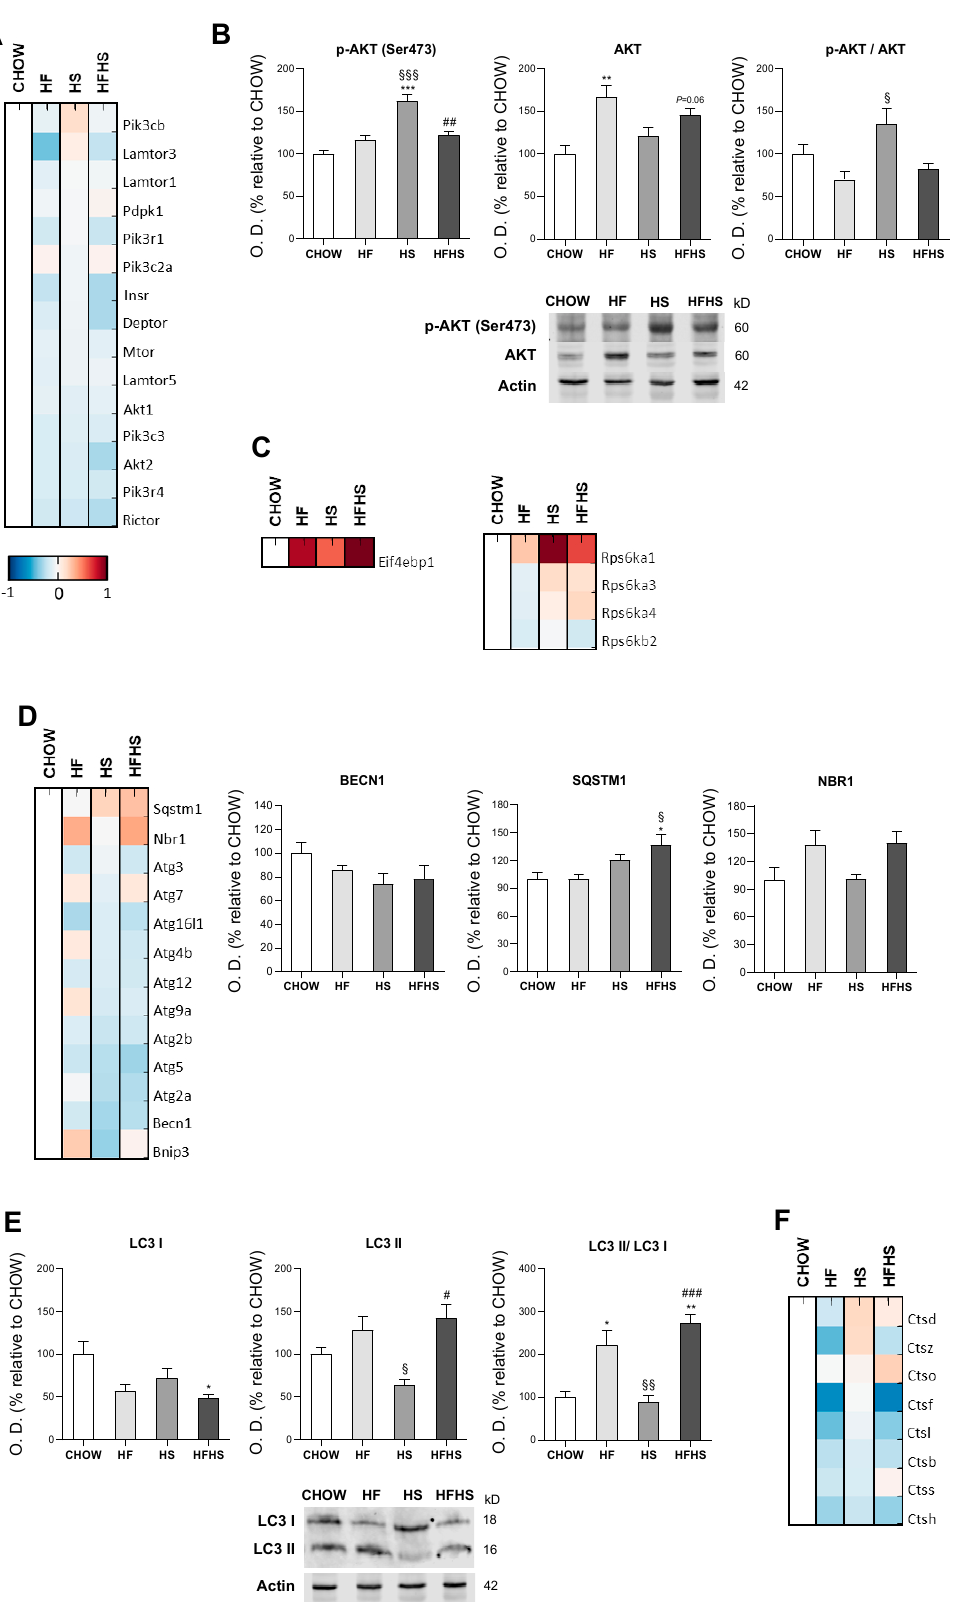
Figure 8. HF and HFHS diets induce SQSTM1 and LC3-II accumulation and reduce cathepsin levels. ( A ) Proteomic analysis of proteins in the PI3K/AKT/mTOR pathway ( N = 4). (B) Optical